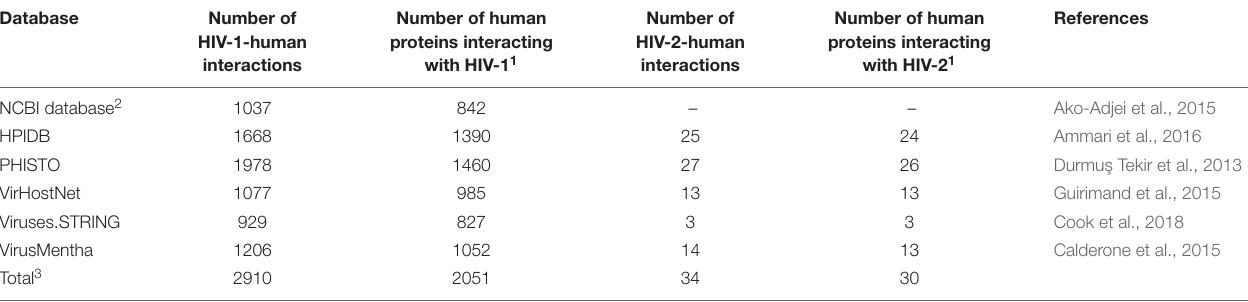
TABLE 1 | Public databases containing data on interactions between HIV and human